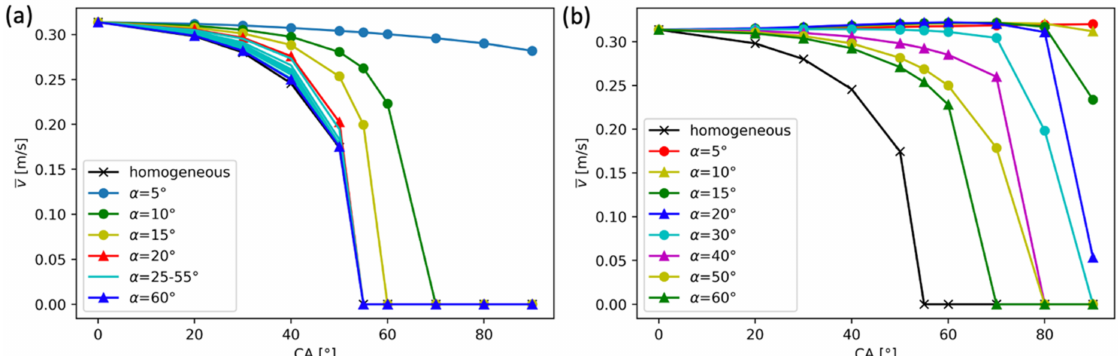
Figure 13. v as a function of CA for body-throat coating pattern: ( a ) body-phobic and ( b ) throat- phobic. The CA is related to the compartments of the particle surface whose wettability is reduced.